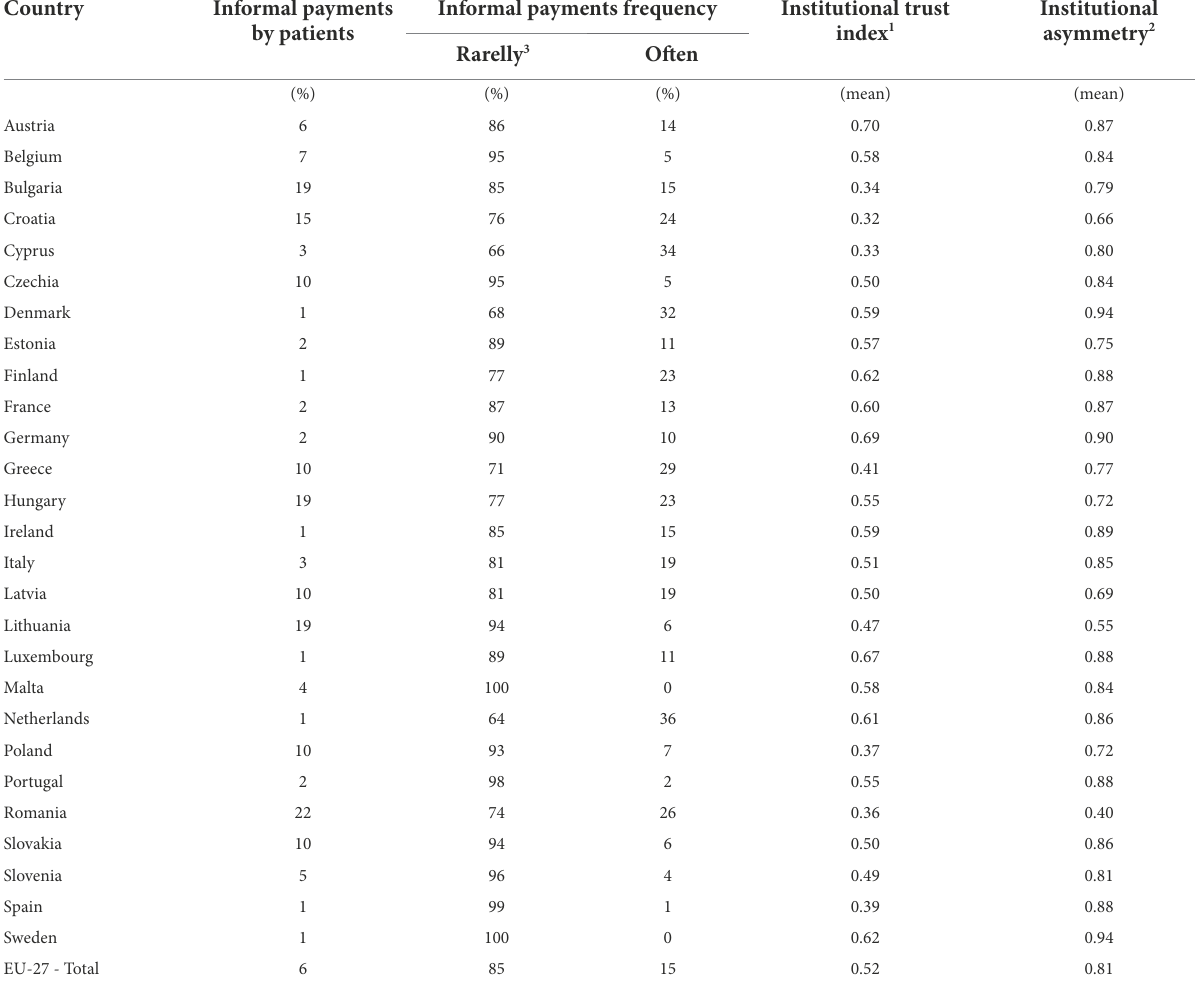
TABLE 2 Informal payments by patients, institutional trust, and institutional asymmetry ( n = 25,744).